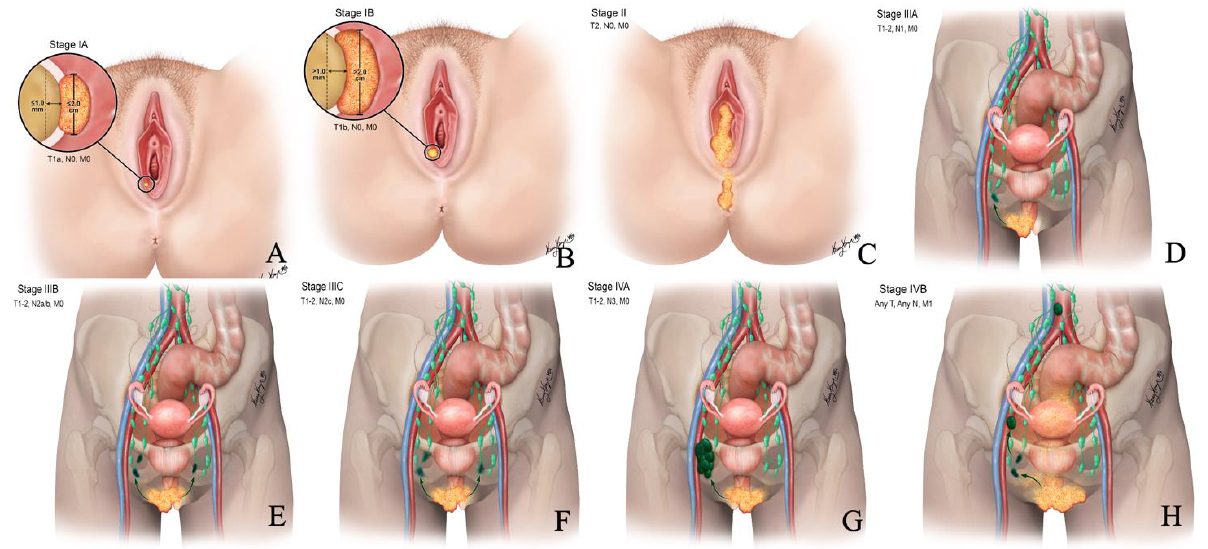
Figure 2. Revised 2021 FIGO staging of vulvar cancer. Stage I tumor confined to the vulva. ( A ) Stage IA tumor size less than equal to 2 cm and stromal invasion less than equal to 1 mm. ( B ) Stage IB tumor size more than 2 cm and stromal invasion more than 1 mm. ( C ) Stage II tumor of any size with extension to lower one-third of the urethra, lower one-third of the vagina, lower one-third of the anus with negative nodes. Stage III tumor of any size with extension to the upper part of adjacent perineal structures or with any number of nonfixed, nonulcerated lymph nodes. ( D ) Stage IIIA tumor of any size with disease extension to the upper two-thirds of the urethra, upper two-thirds of the vagina, bladder mucosa, rectal mucosa, or regional lymph node metastases less than equal to 5 mm. ( E ) Stage IIIB regional lymph node metastases more than 5 mm. ( F ) Stage IIIC regional lymph node metastases with extracapsular spread. Stage IV tumor of any size fixed to bone or fixed, ulcerated lymph node metastases, or distant metastases. ( G ) Stage IVA disease fixed to the pelvic bone or fixed or ulcerated regional lymph node metastases. ( H ) Stage IVB distant metastases.